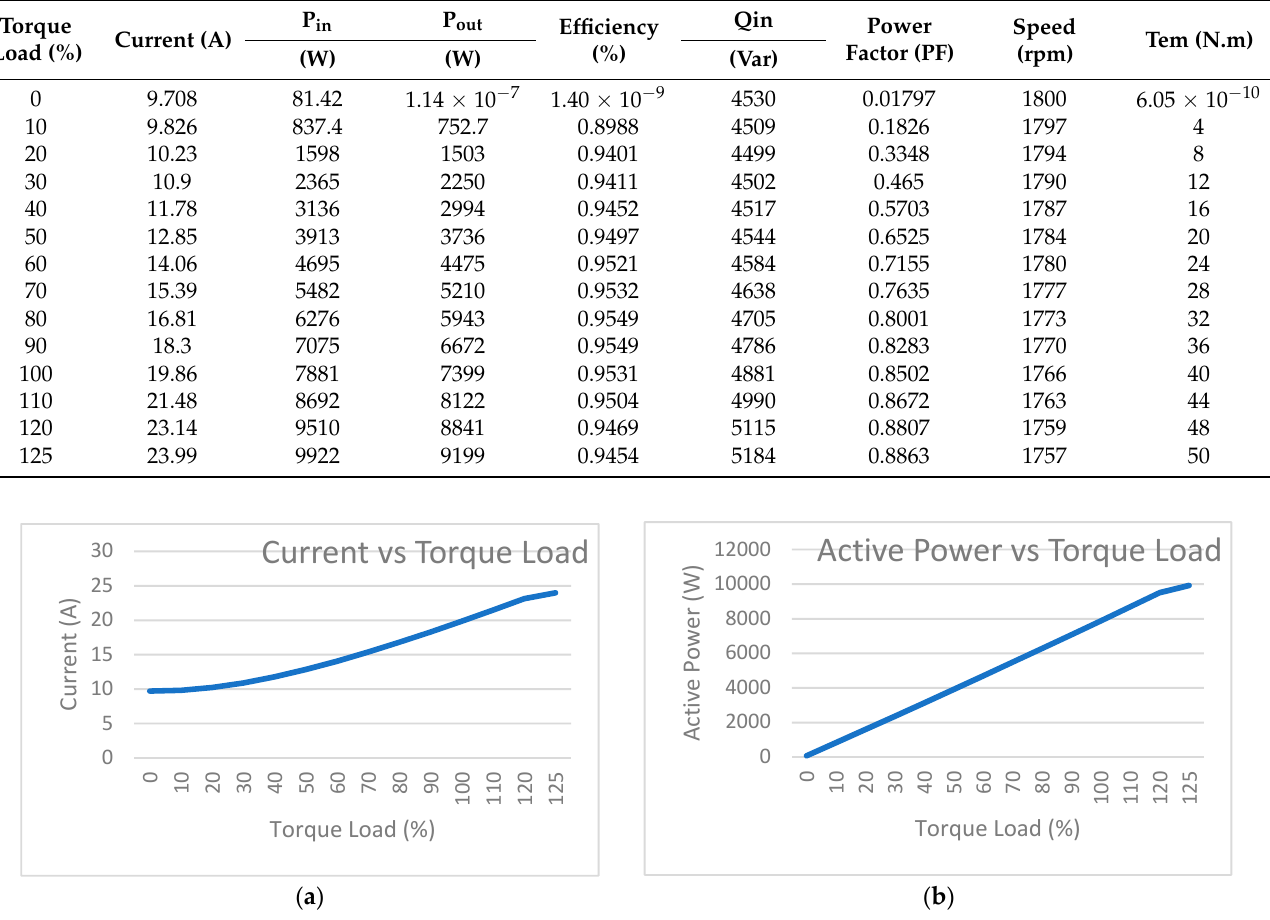
Figure 13. ( a ) Current vs torque load; ( b ) active power vs torque load.